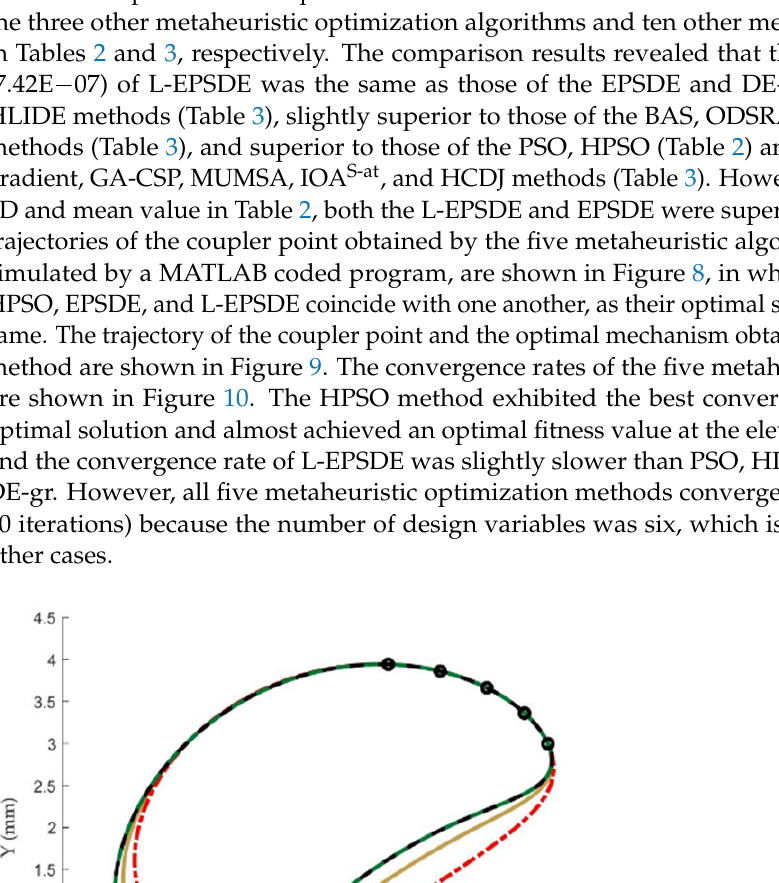
Figure 9. Trajectory of the coupler point of Case 1. Figure 10. Convergence rate of the five metaheuristic methods for Case 1. Case 2: Irregular closed curve (18 target points, 10 design variables). This is a representative problem for the synthesis of path generation with prescribed timing, where 18 target points are specified in an irregular closed curve. This well-known problem was originally proposed by Kunjur and Krishnamarty [39], and has been solved by numerous researchers. The problem is defined as follows: The coordinates of eighteen target points (unit: mm):